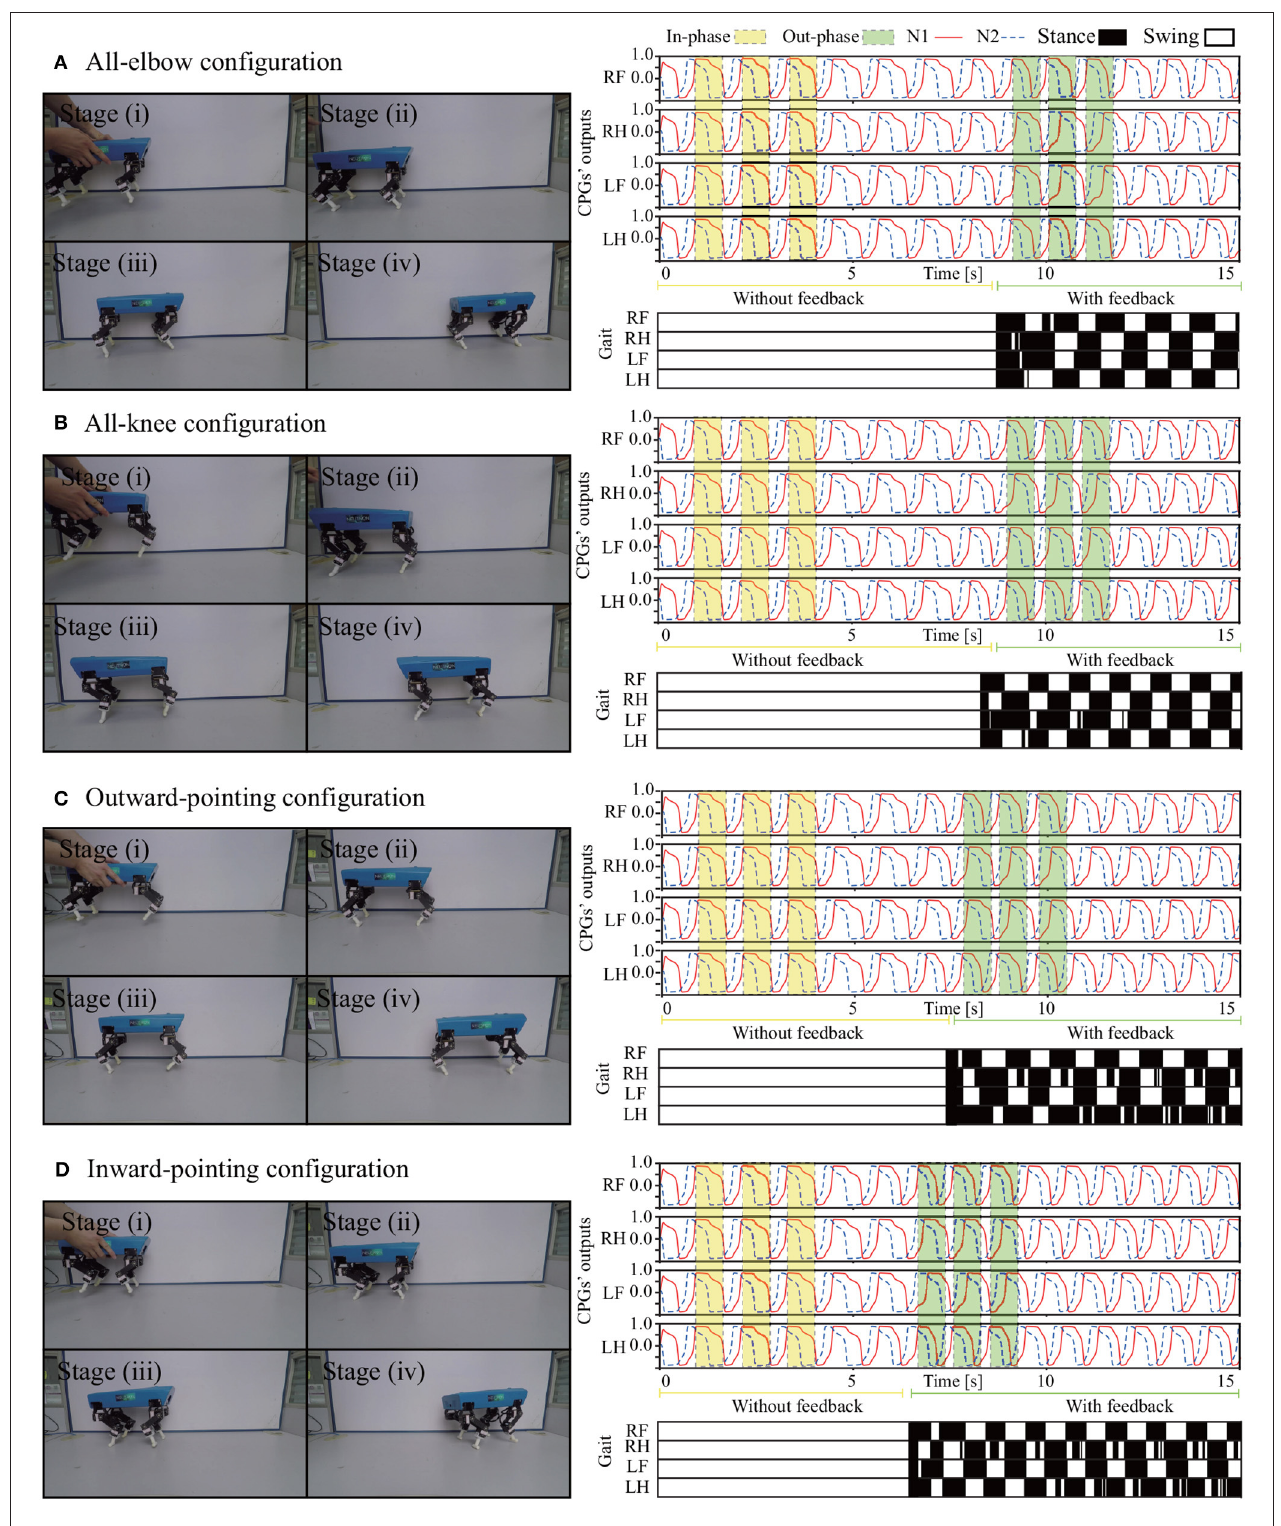
FIGURE 9 | Process of self-organized locomotion generation under four leg orientation types, as indicated in (A–D) . (A) All-elbow configuration. (B) All-knee configuration. (C) Outward-pointing configuration. (D) Inward-pointing configuration. The outputs of the CPGs started in phase, and once the robot interacted with the ground, the phases began to be adjusted by the GRFs. The gaits quickly emerged within 8 s.